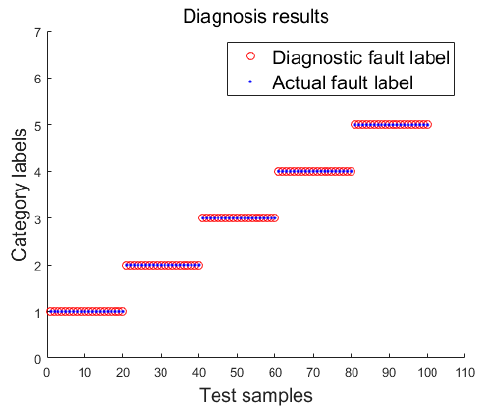
18 of 21 Figure 22. Classification result under condition 1.